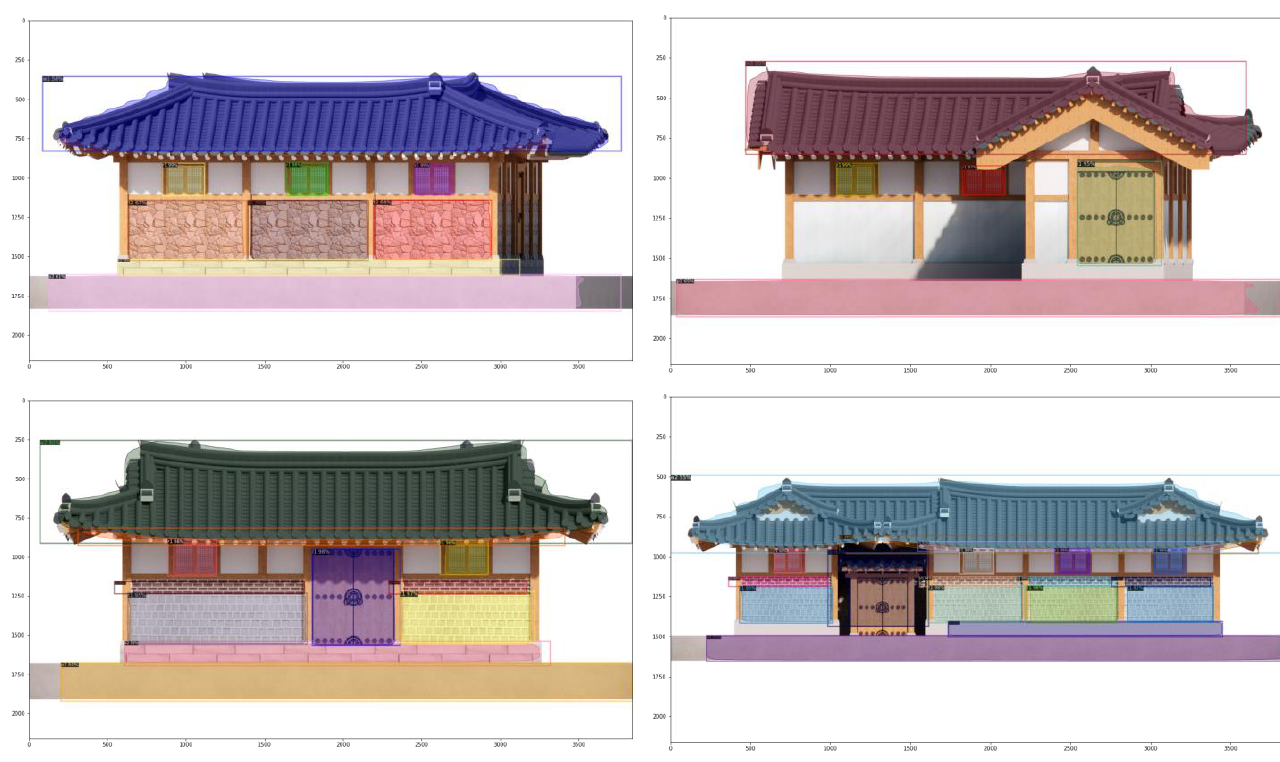
Figure 17. Segmentation results of Hanok image.